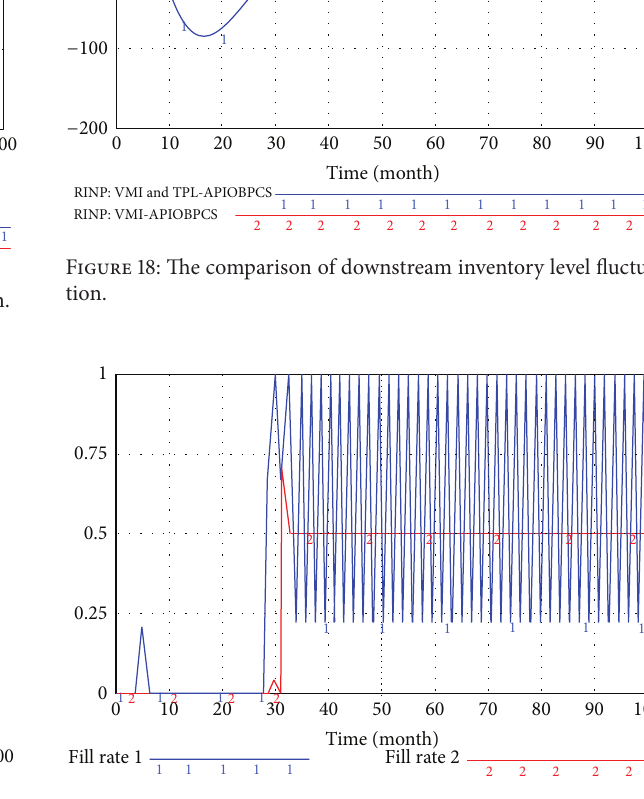
Figure 19: Service levels in the VMI operation mode. integrated operation mode, the average service level of two retailers is